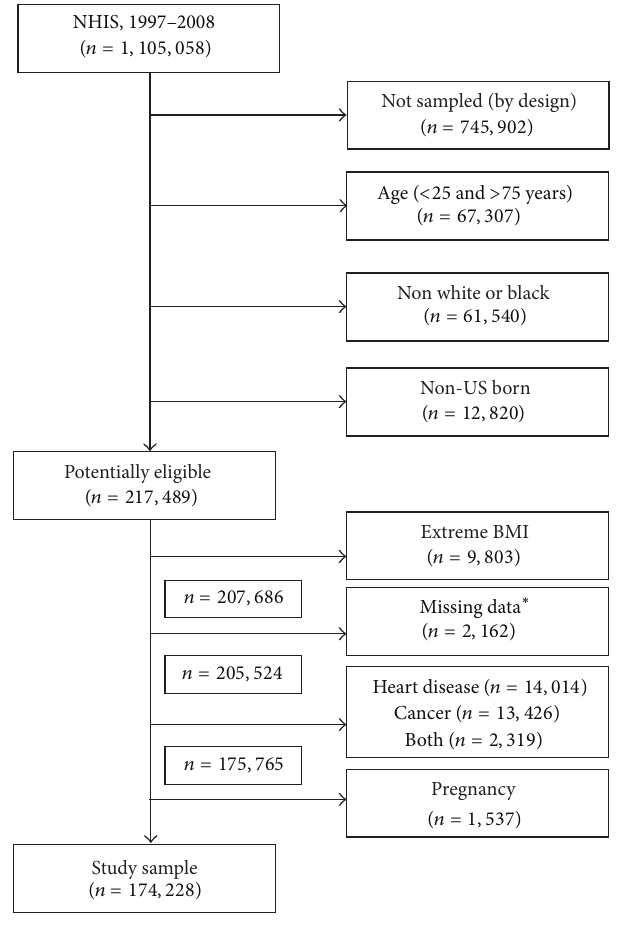
Figure 1: Study flow